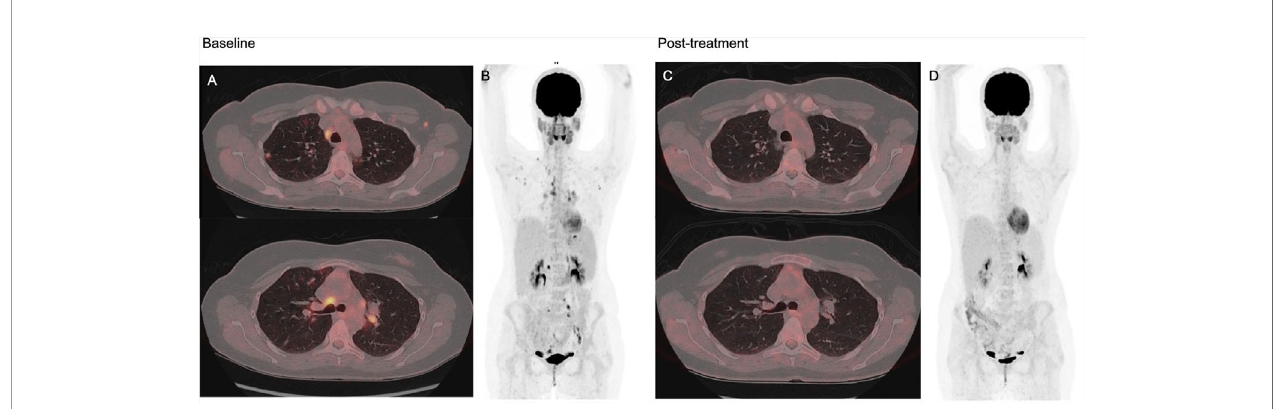
FIGURE 7 | FDG PET/CT at baseline and 3 – 4 months after monotherapy with rituximab in a 37-year-old common variable immunode fi ciency (CVID) patient with granulomatous-lymphocytic interstitial lung disease (GLILD) and generalized lymphadenopathy. Image (A) shows axial fused PET/CT images at two different thoracic levels at baseline, with scattered nodular and con fl uent consolidations in the pulmonary parenchyma with moderate to high FDG uptake, and also moderate to high FDG uptake in mediastinal and hilar lymph nodes. Image (B) shows baseline maximum intensity projection (MIP) showing pathologic FDG uptake in lung parenchyma and lymph nodes over and under the diaphragm. Image (C, D) shows post-treatment axial fused FDG PET/CT and MIP with complete resolution of both pulmonary and lymph node pathology. Spleen size was within normal range both before and after